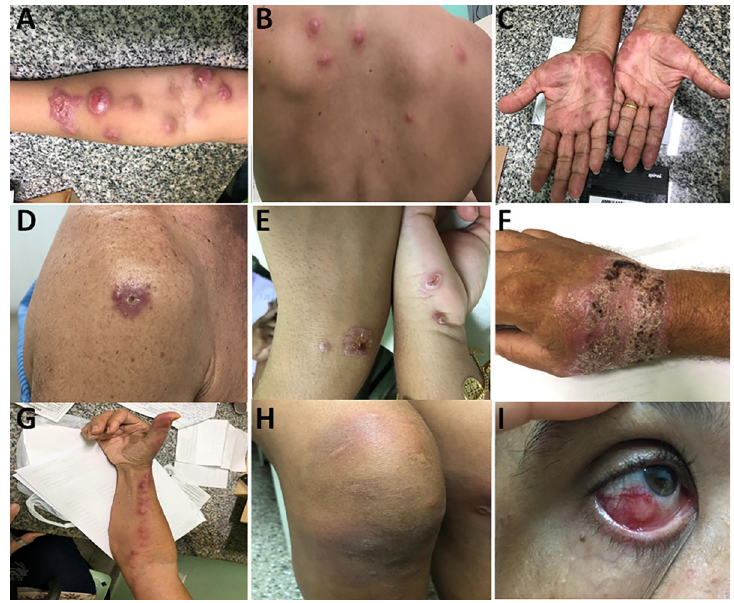
Fig 1. Clinical forms of cat-transmitted subcutaneous sporotrichosis of patients seen in Rio Grande do Norte state, Northeast Brazil. A = lymphocutaneous form. B = erythema nodosum. C = Polymorphic erythema. D = Fixed cutaneous form. E = Ulcer-crusted lesion. F = Crusted-plaque lesion. G = Sporotrichotic rosary. H = Reactive arthritis (arthralgia). I = Conjunctival